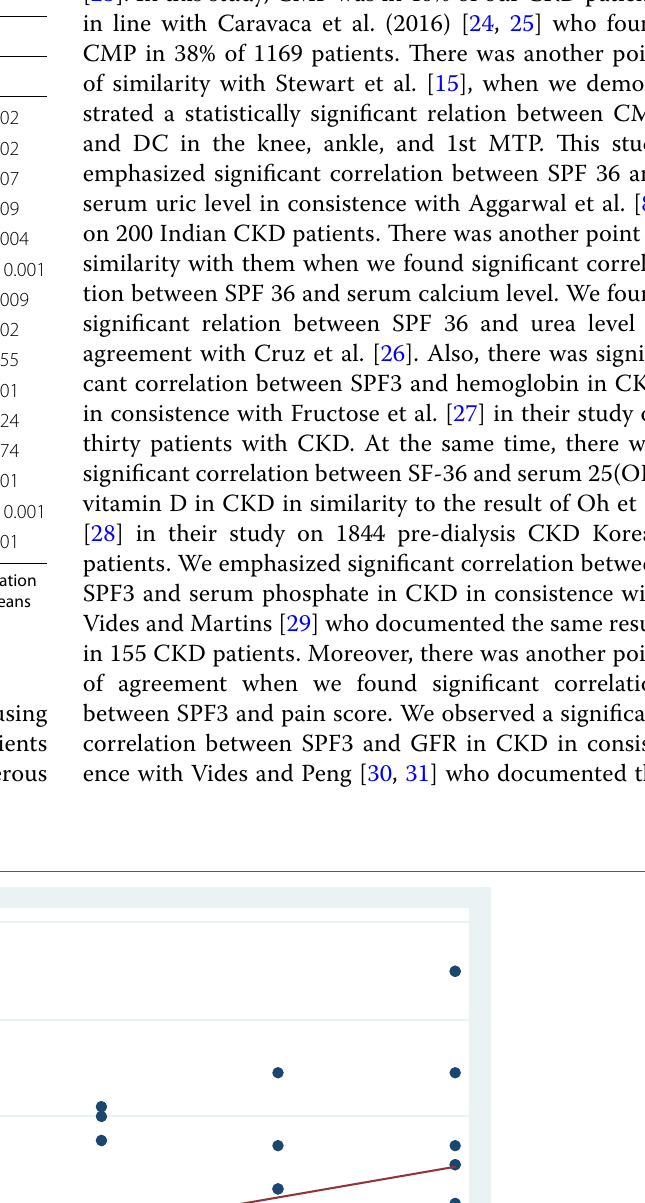
Table 4 Relation between quality of life and clinical laboratory findings in CKD patients